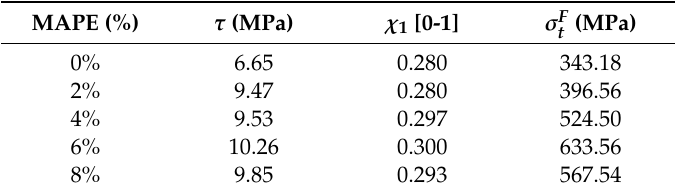
Table 4. Micromechanic parameters of the 30 wt.% CSF reinforced BioPE composites obtained by using Kelly and Tyson modified